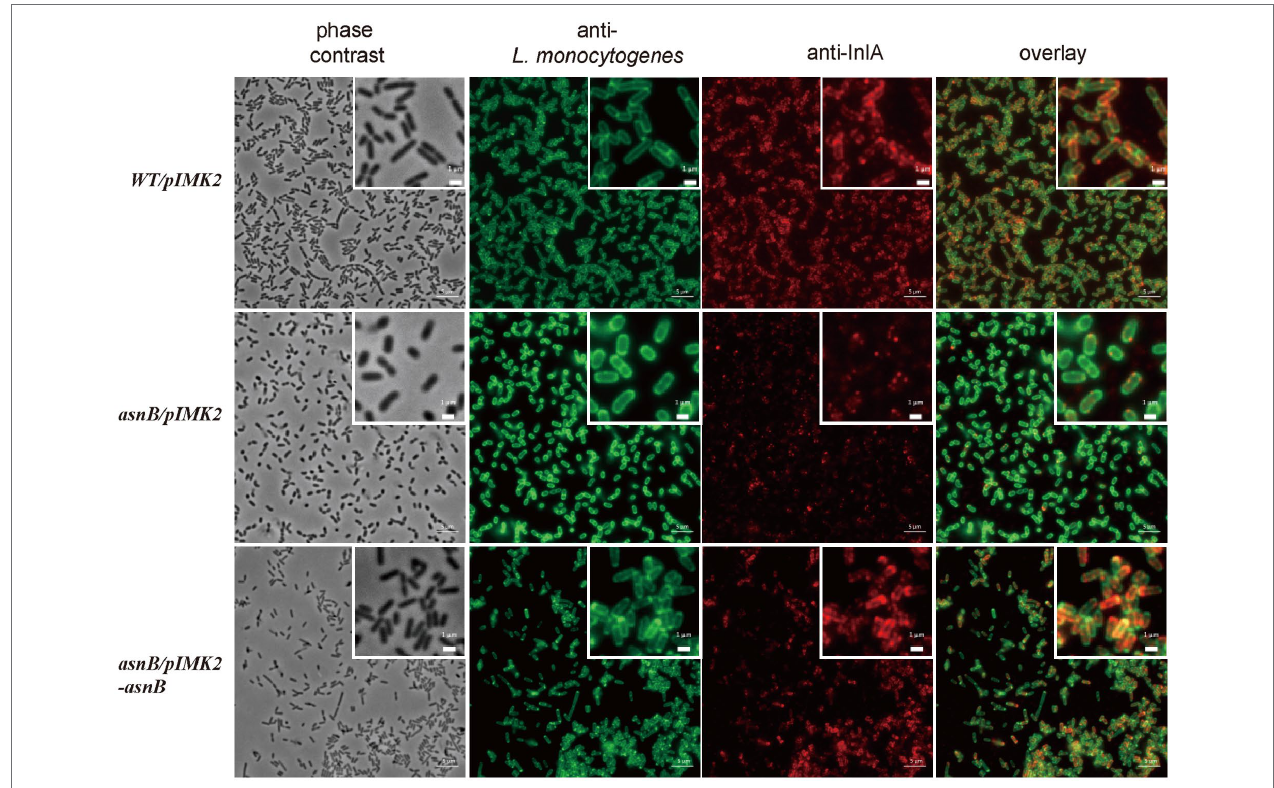
FIGURE 8 | Immunofluorescence microscopy analysis of the invasion protein InlA on the surface of L. monocytogenes WT/pIMK2 , asnB/pIMK2 , and asnB/pIMK2- asnB strains. Bacteria were visualized using phase contrast microscopy (first lane) and with immunofluorescence staining with a polyclonal anti- L. monocytogenes antibody (second lane) and a mixture of two monoclonal anti-InlA antibodies (third lane). Bacteria (in green) and InlA (in red) are shown together in an overlay composition (last lane). Scale bar 5 μ M. A higher magnification is shown on the upper right corner. Scale bar 1 μ